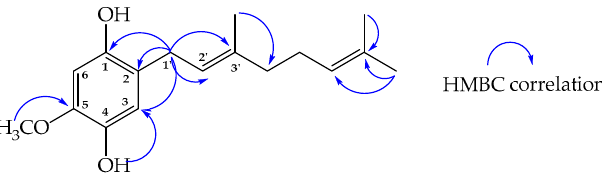
Figure 4. Major 2D HMBC observed correlations for Compound 17 .